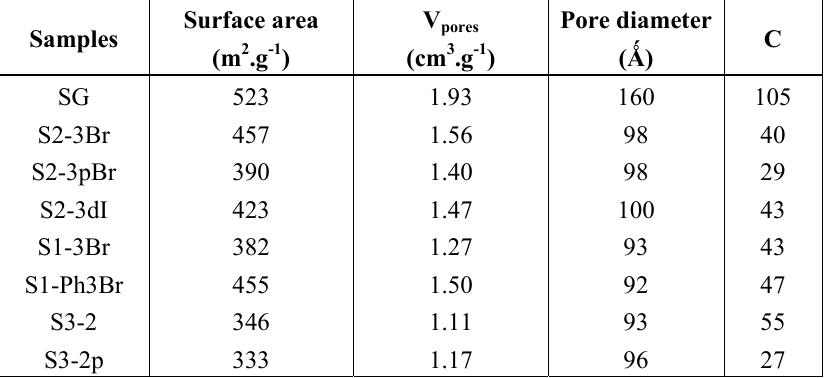
Table 1. Textural properties of supported